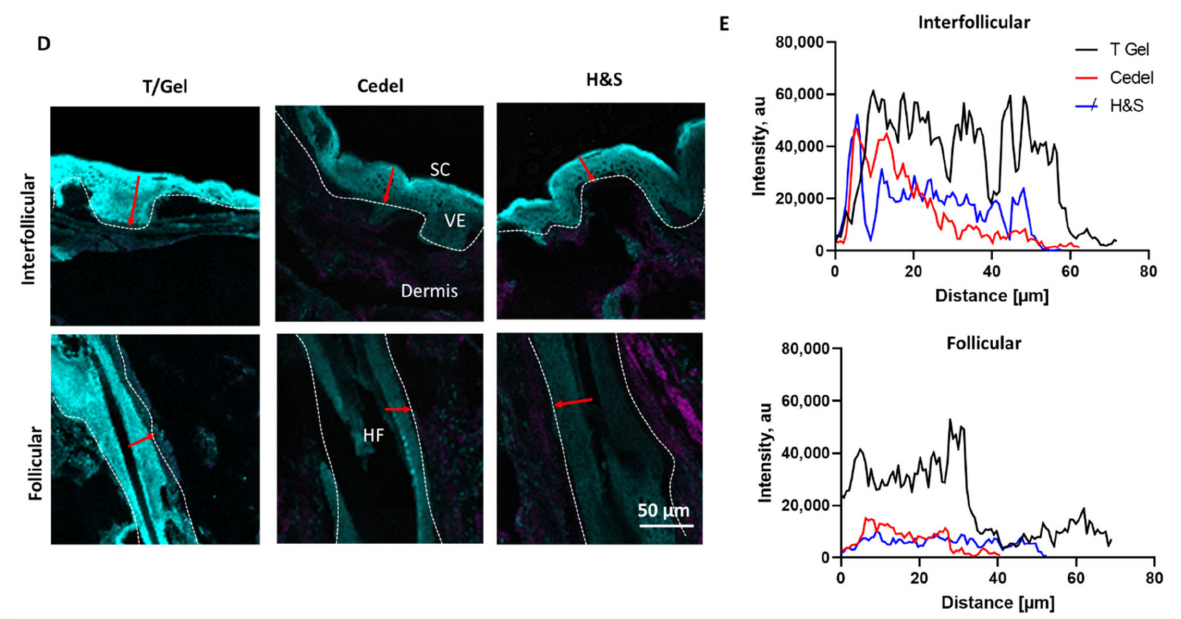
Figure 5. Elevated labile zinc within the viable epidermis from ZnPT treatment . ( A ) MPM of inter- follicular/surface skin from control and ZnPT treatment. ( B ) MPM images of follicular skin. ( C ) Cor- responding Zinpyr-1 intensity profiles. SC, stratum corneum; HF, hair follicle; VE, viable epidermis. ( D ) MPM of interfollicular and follicular skin from commercial product treatment. ( E ) corresponding intensity profiles (top graph, interfollicular, bottom graph,